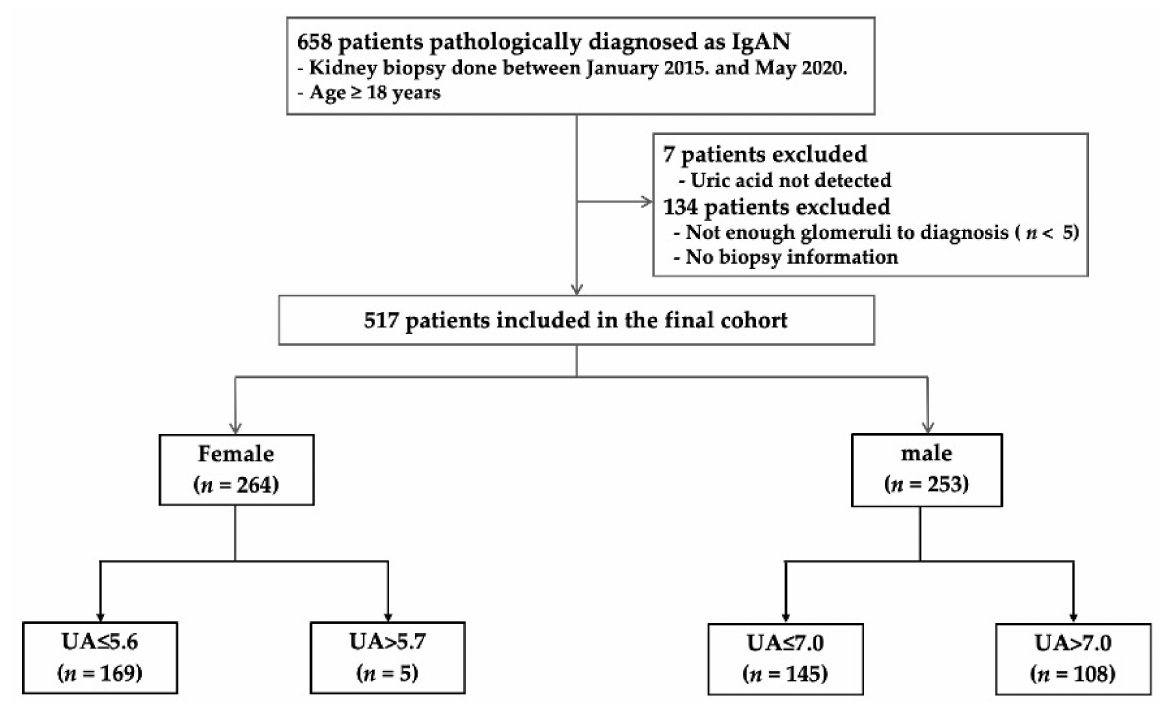
Figure 1. Flow diagram for the study